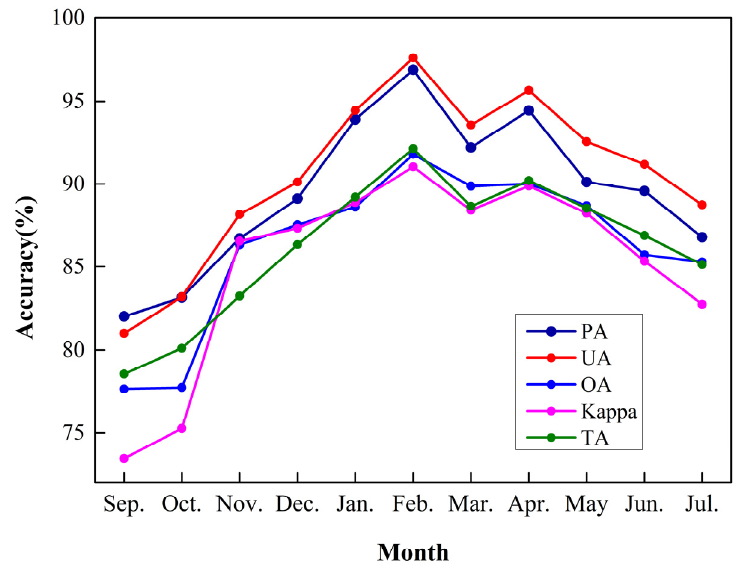
Figure 3. Results of accuracy indicators for each month.